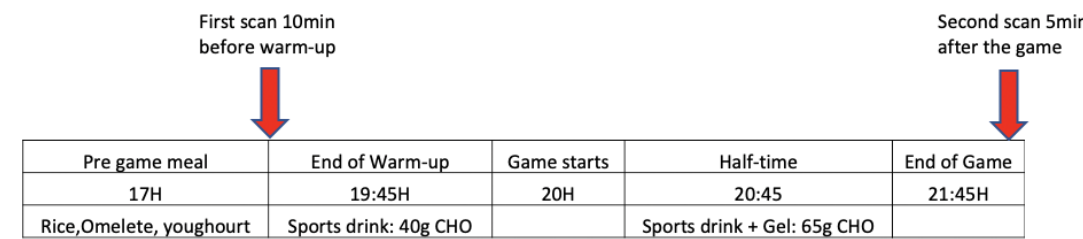
Table 1. Nutritional and carbohydrate protocol followed before the game and at half-time.